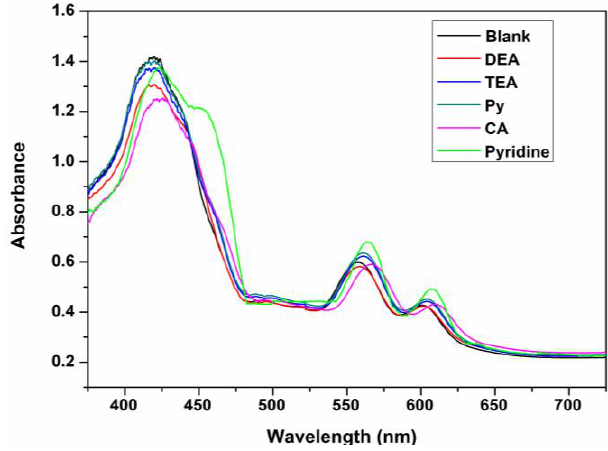
Figure 8. Absorption spectra of the ZPCPI nanofibrous membrane exposed to different vapors ( λ = 420 ex